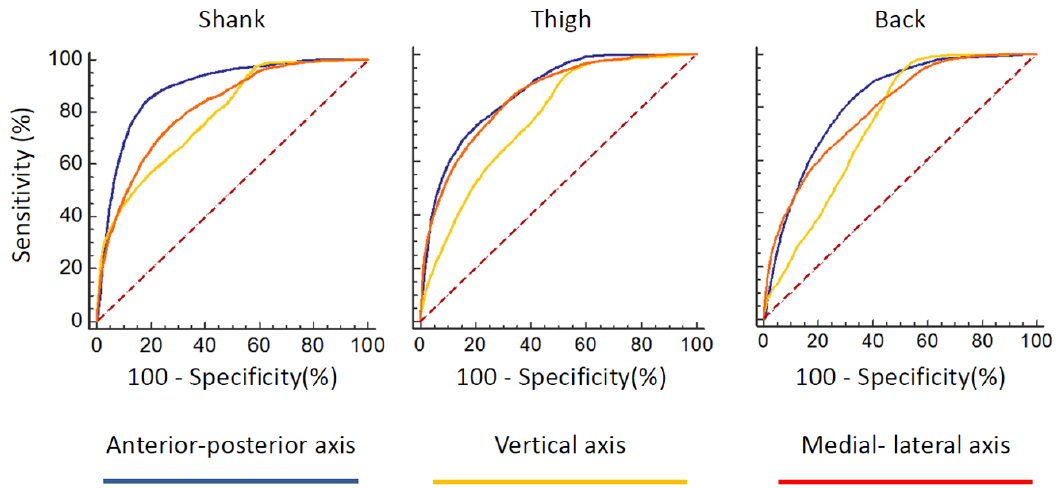
Figure 2. Receiver operating characteristic (ROC) curves for all sensors and all the three axes. Table 1. Area under the ROC curve across all the subjects for the different sensor positions and axes.